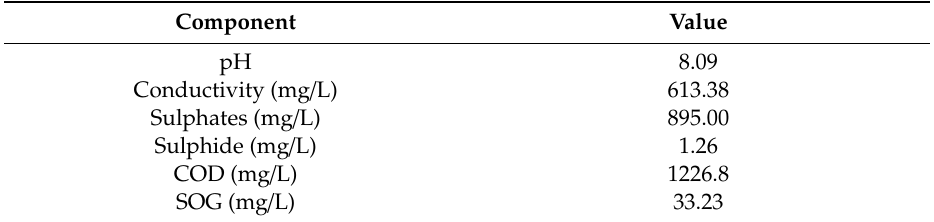
Table 1. Properties of oily wastewater before treatment. COD: chemical oxygen demand, SOG: soap oil and grease.